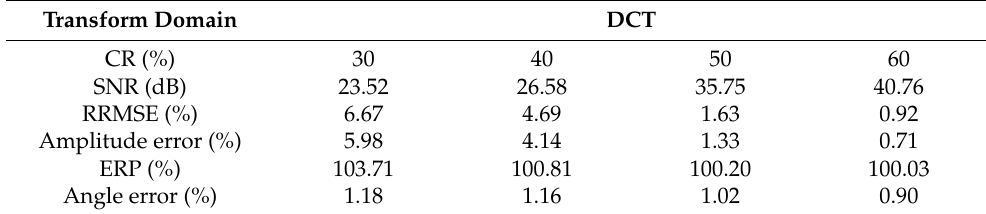
Table 11. Reconstruction results of the fluctuant signal in the DCT domain.